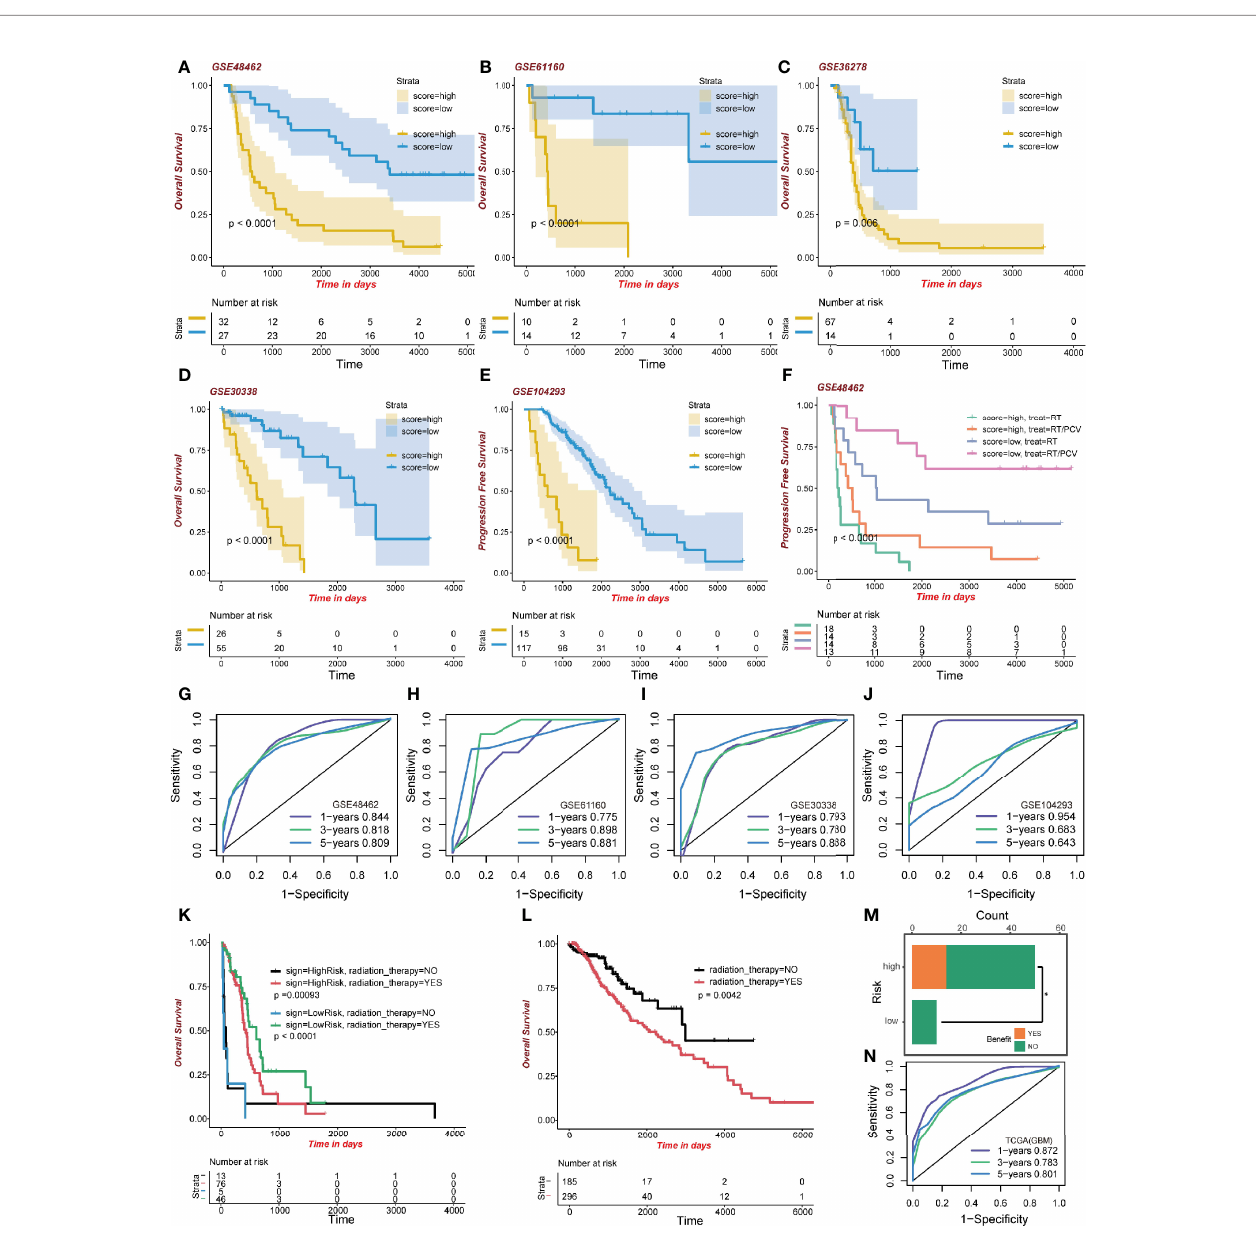
FIGURE 6 | Validation of the signature. (A – E) Kaplan-Meier curve of high-risk and low-risk score groups in the GEO cohort. (F) Kaplan-Meier survival analysis of different treatments on the GSE48462 dataset. Both high-risk and low-risk groups bene fi ted from PCV. (G – J) ROC curve of the GEO dataset. (K) Kaplan-Meier curve of radiation therapy in the high- and low-risk GBM dataset group of TCGA. (L) Kaplan-Meier curve of radiation therapy in the LGG dataset group of TCGA. (M) Bene fi t from RT/PCV treatment in the GSE48462 dataset. (N) ROC curve of the GBM dataset group in TCGA.